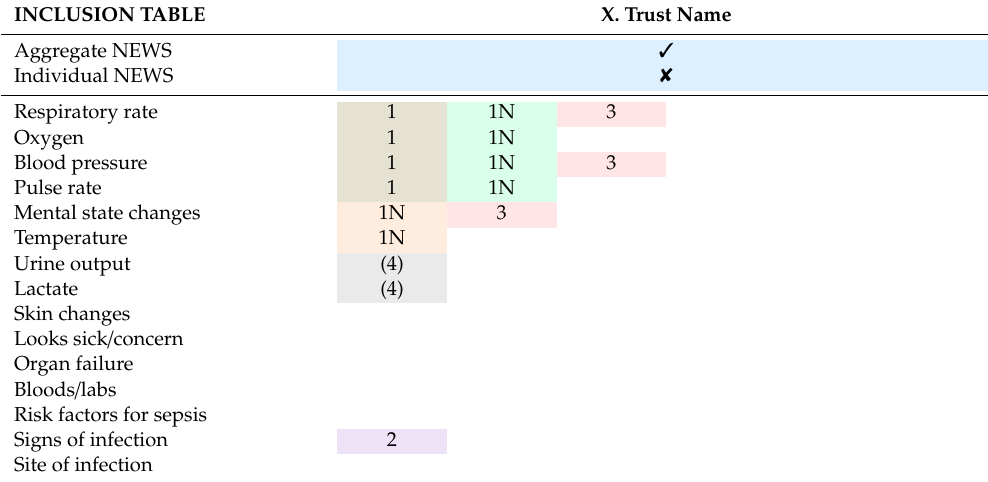
Table A2. Inclusion table with information from a sepsis